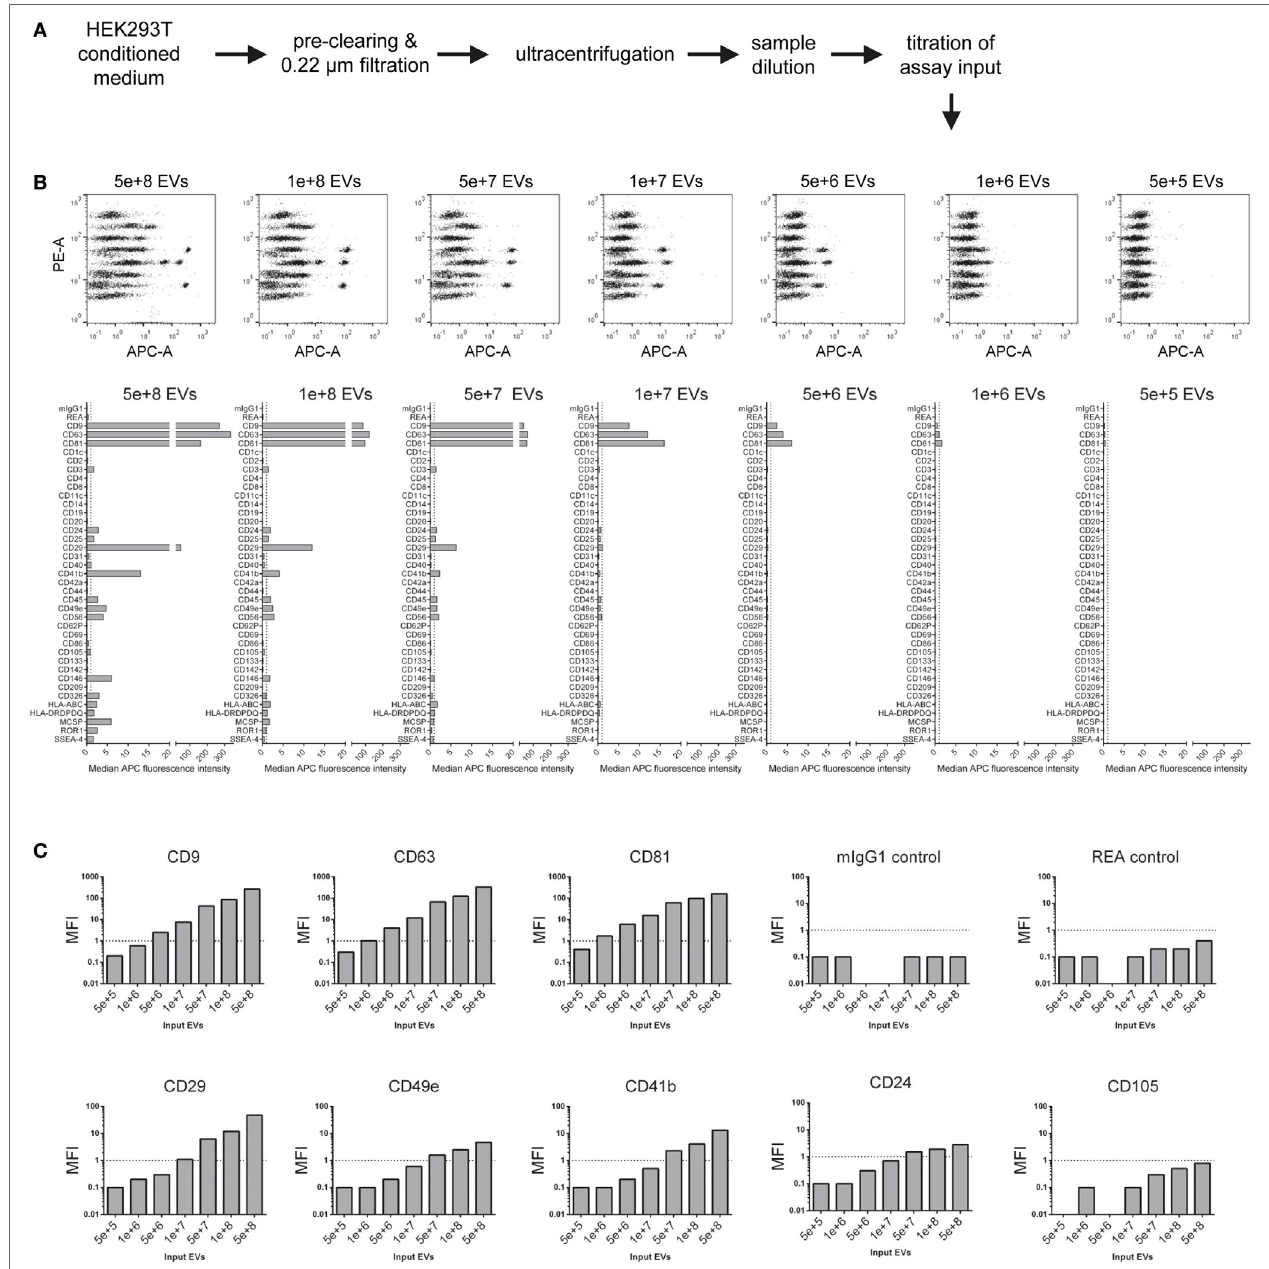
FigUre 2 | Evaluation of assay range of detection and titration of assay input. (a) Experimental outline. The concentration of HEK293T-derived extracellular vesicles (EVs) was quantified via nanoparticle tracking analysis, and defined doses of EVs were used as assay input. (B) Assay results shown for a range of 5 × 10 5 –5 × 10 8 particles per assay. (c) Same experimental dataset as shown in (B) sorted by different markers Vs. isotype controls, demonstrating that more abundant markers (e.g., CD63) can be still detected at relatively low input doses, while less abundant markers (e.g., CD49e) require higher input doses, in this case above 1 × 10 8 particles for reliable detection of signal above background levels. Further details are provided in Table S2 in Supplementary